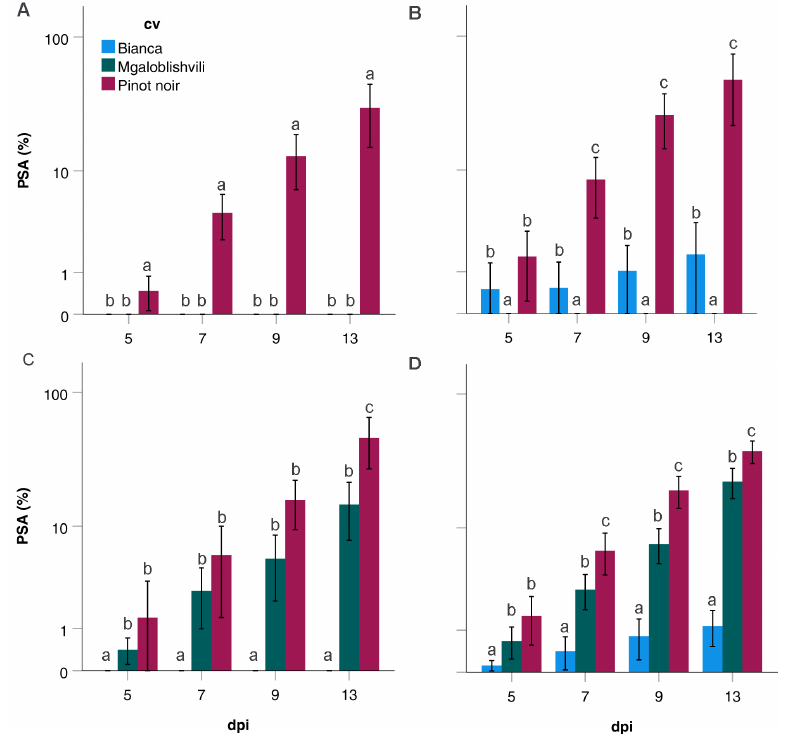
Figure 4. PSA values (%) recorded on Bianca, Mgaloblishvili, and Pinot noir from 5 to 13 dpi by P. viticola isolates grouped in PC1 ( A ), PC2 ( B ), PC3 ( C ), and PC4 ( D ). Different letters within dpi indicate the existence of significant differences among IF values on the different cultivars ( p < 0.05).